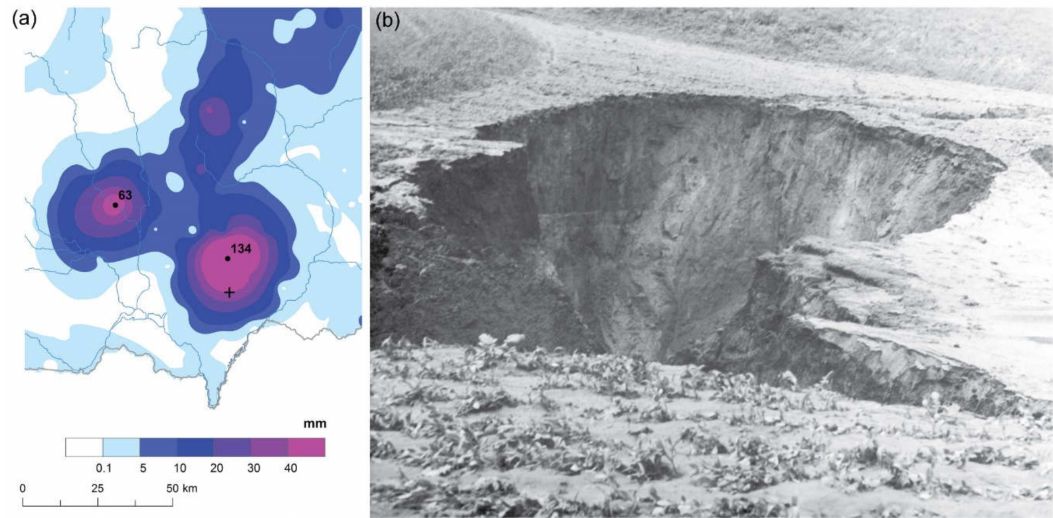
Figure 10. ( a ) Spatial distribution of precipitation on 9 June 1970 in the southeastern Moravia (maximum totals in two core areas: 63 mm at Brno-Kn í niˇcky (240 m asl), 134 mm at Žd á nice; the + symbol indicates Šardice); ( b ) a crater created by the collapse of the upper part of the Dukla mine at Šardice